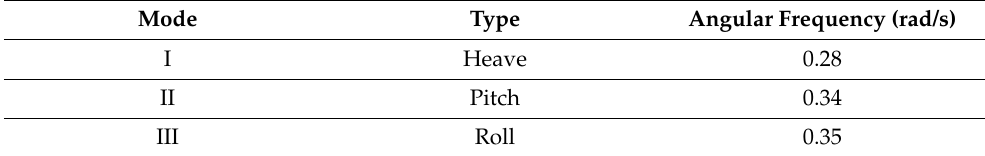
Table 9. Natural modes of the floating platform.